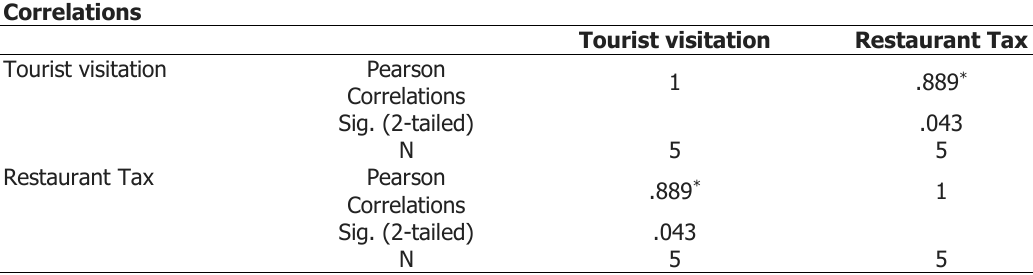
Table 4. Correlation Coefficient of Variable X with